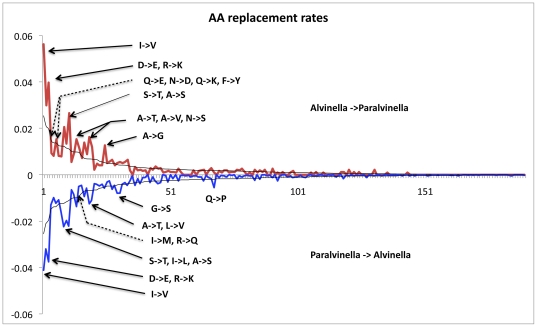
Observed and expected distributions of oriented amino-acid substitutions between P. grasslei and A. pompejana.Detection of amino acid substitutions that significantly depart from the neutral expectations of the WAG matrix. Blue and red lines correspond to the observed directional frequencies of residue replacements (eg. A→G and G→A) observed between the two alvinellid species. The black lines correspond to the expected directional frequencies of amino acid substitutions obtained using the WAG matrix multiplied by amino-acid frequencies typifying the two alvinellid worms. Arrows show ‘outlier’ substitutions that significantly depart from neutral evolution using the Normal distribution of differences at a 5% threshold.